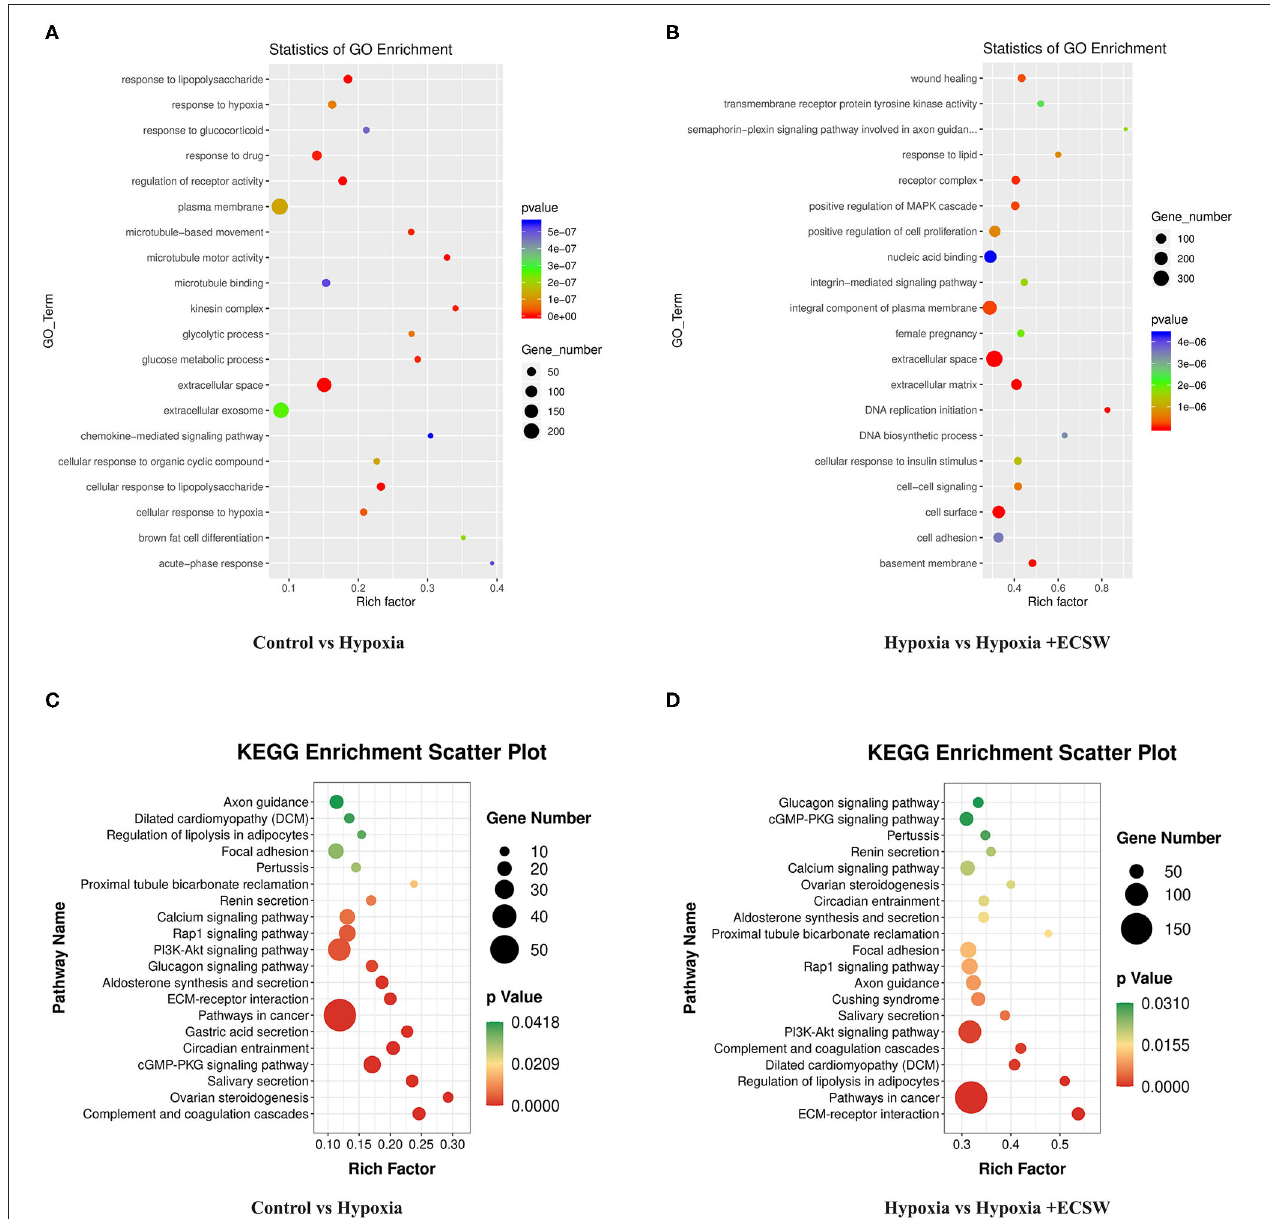
FIGURE 2 | Bioinformatic analysis of differentially expressed genes (DEGs). (A,B) Functional annotation of DEGs based on Gene ontology analysis. (A) Hypoxia group EPCs represent the treatment group, Control group EPCs are the negative control. (B) Hypoxia + ECSW group EPCs are the treatment group, Hypoxia group EPCs are the negative control. (C,D) Functional annotation of differentially expressed mRNAs based on KEGG pathway analysis. (C) Hypoxia group EPCs are the treatment group, Control group EPCs are the negative control. (D) Hypoxia + ECSW group EPCs are the treatment group, Hypoxia group EPCs are the negative